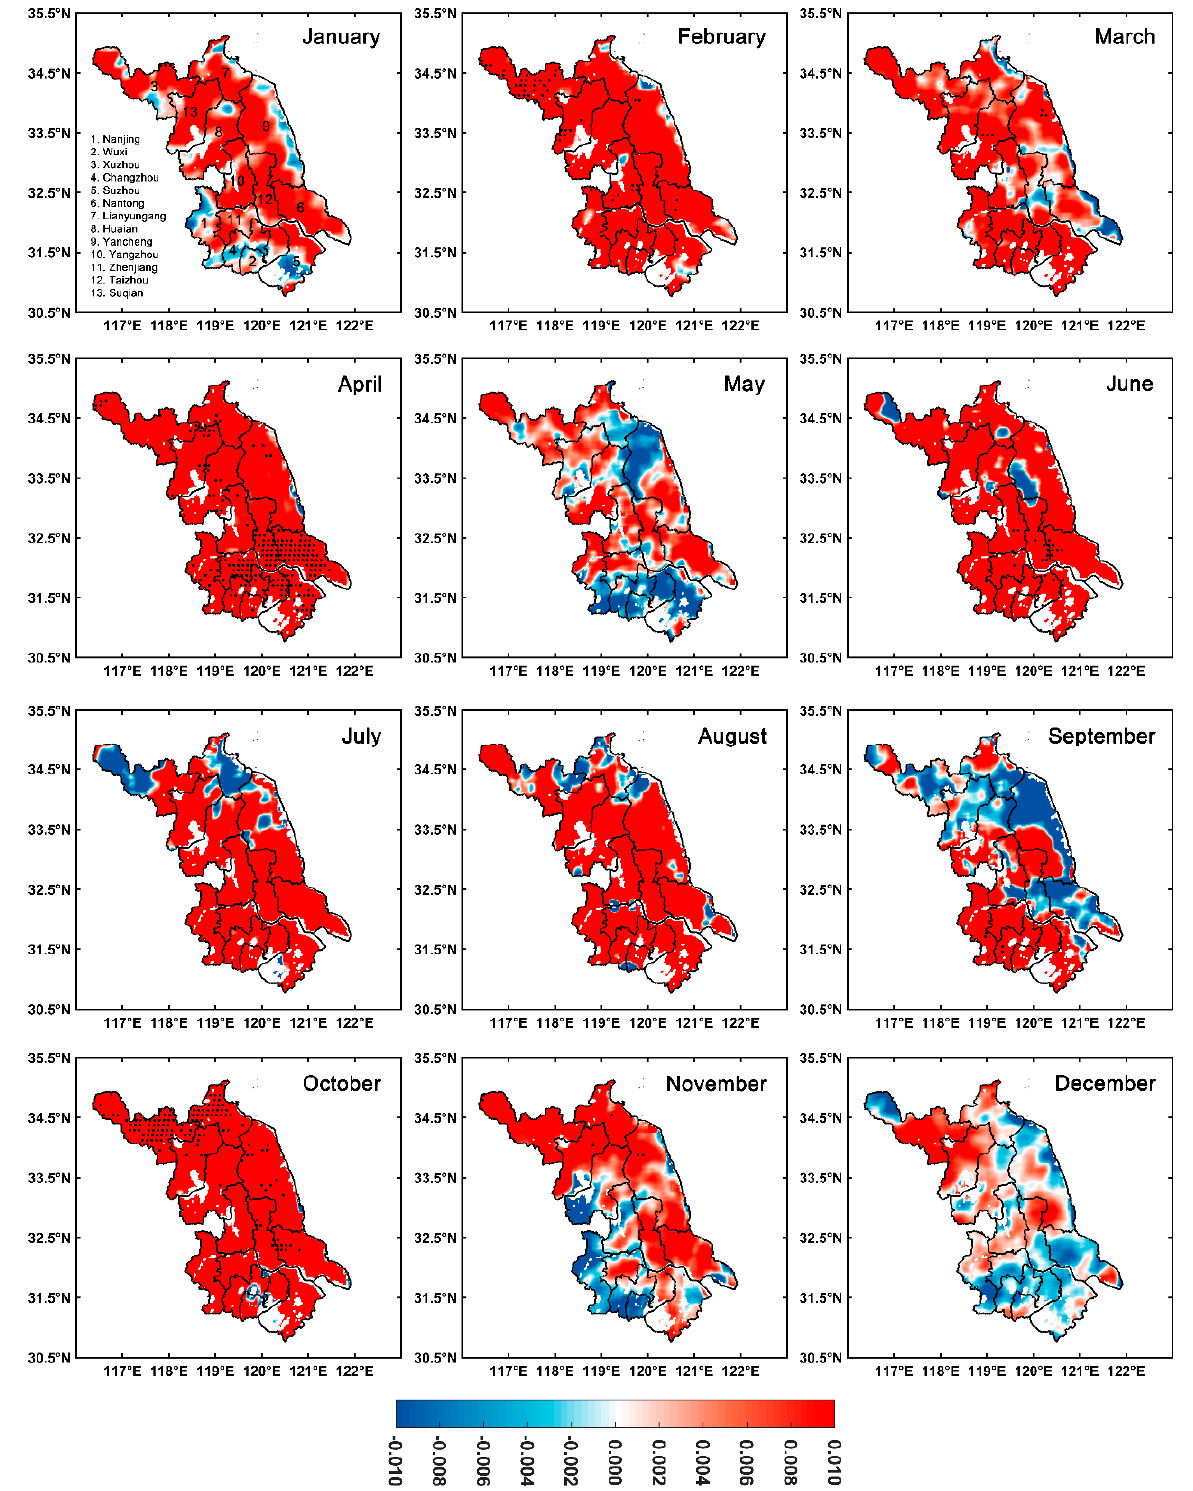
Figure 9. Monthly spatial trends of high-resolution MODIS MAIAC AOD from 2000 to 2009 in Jiangsu province. The dot (.) symbol indicates significance at 95% confidence interval.